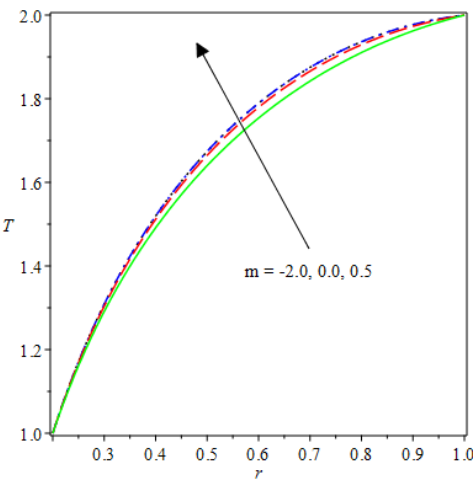
Figure 5. Temperature field for rising ( m ) .